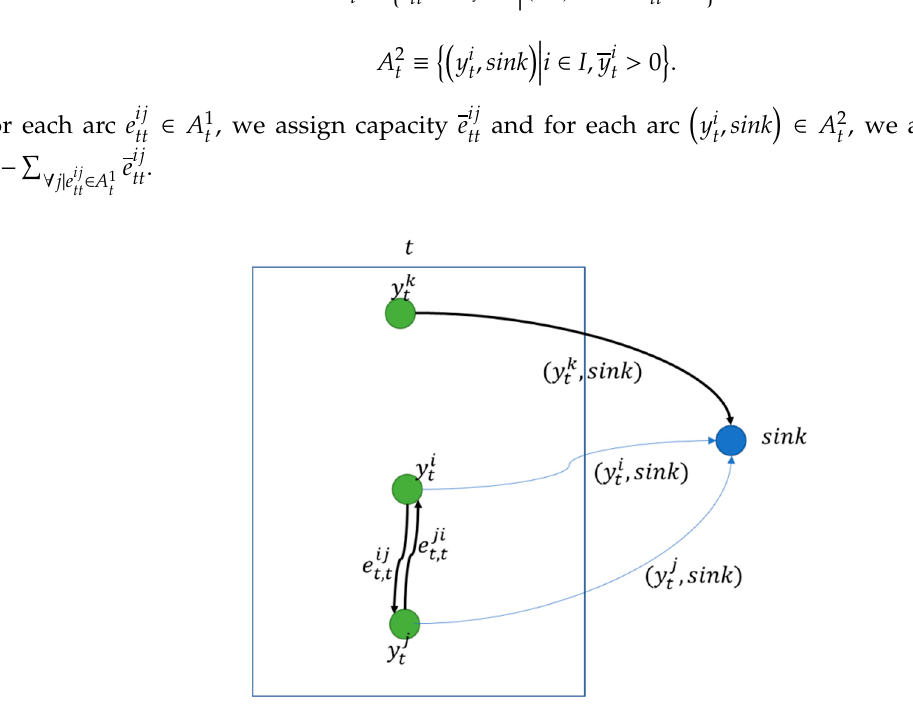
(cid:16) (cid:17) V t , A t for bucket t for the use of cut-based